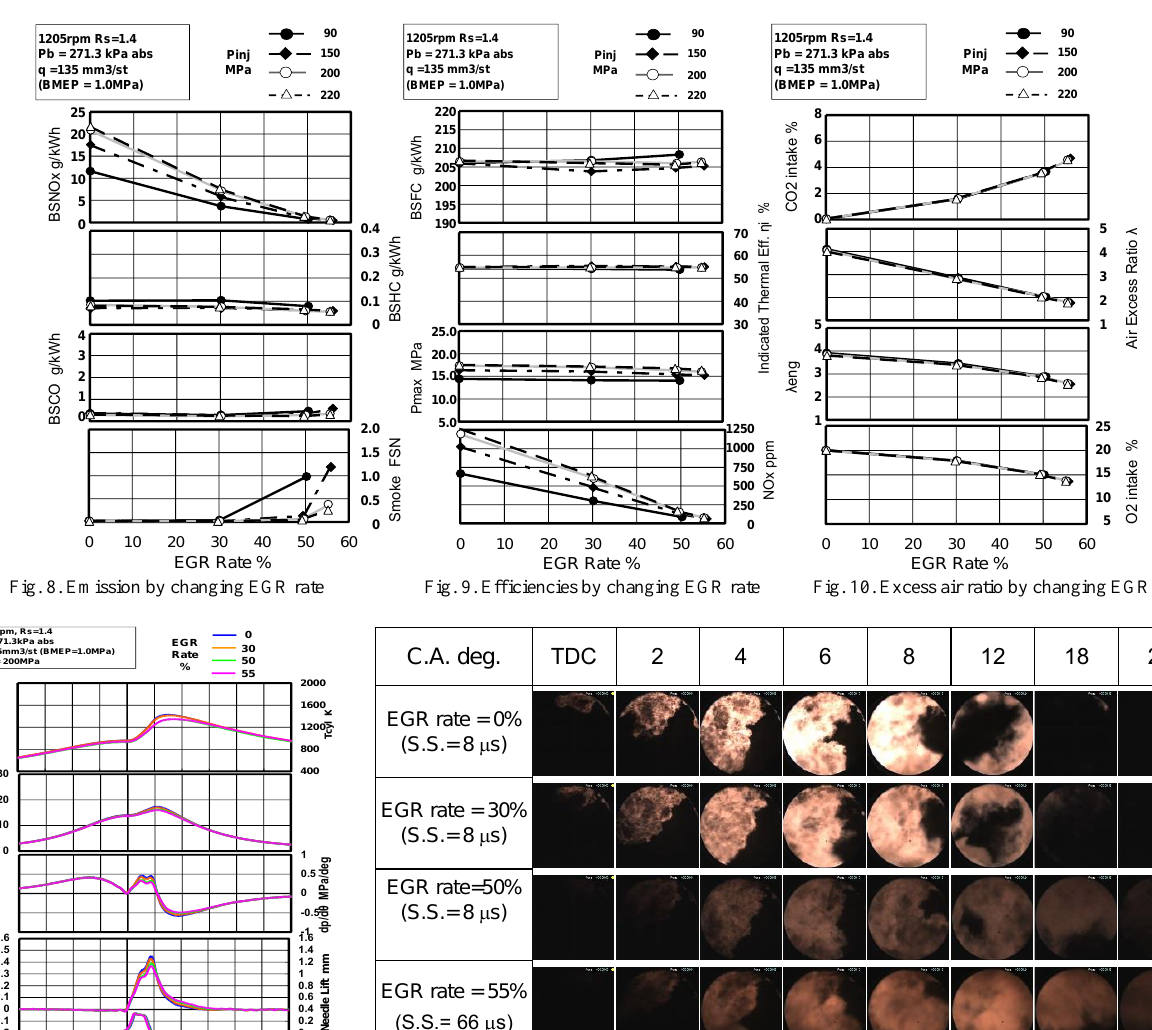
Fig. 12. High speed flame photos with borescope by changing EGR